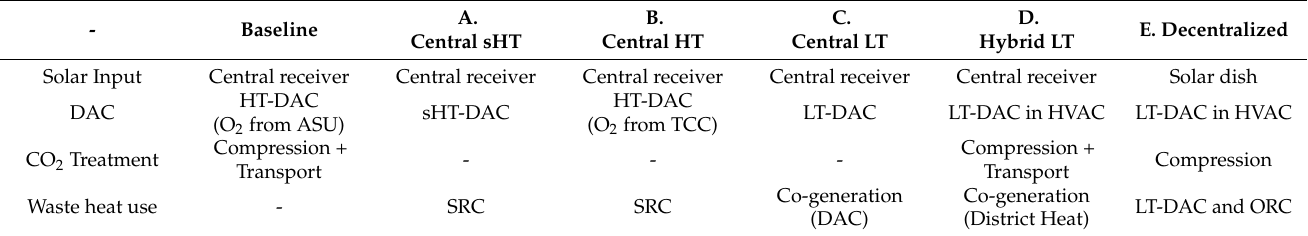
Table 2. Description of the five considered scenarios and comparison with baseline. The terms “Co-generation (DAC)” and “Co-generation (District Heat)” refer to directly using the heat of the condenser to regenerate the LT-DAC units or to power a district heating grid, respectively. ASU means air separation unit, while HVAC stands for heating, ventilation and air conditioning. The acronyms SRC and ORC refer to steam and organic Rankine cycle,